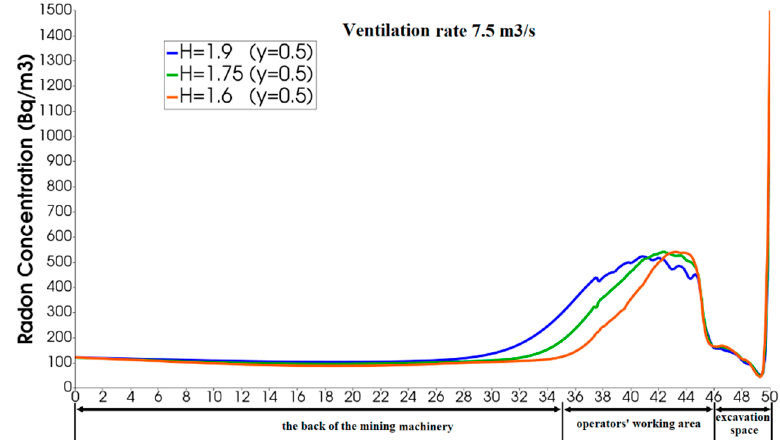
Figure 11. Inhaled radon concentrations along the non-duct side of laneway at different ventilation rates.